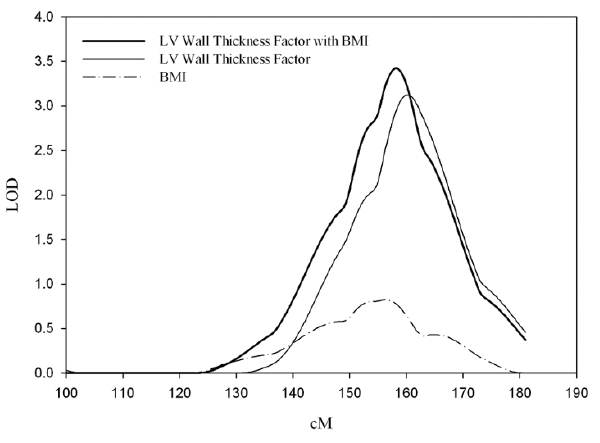
Bivariate and univariate linkage plots for LV wall thickness factor and body mass index (BMI) . Same labels for x- and y- axes as in Figure